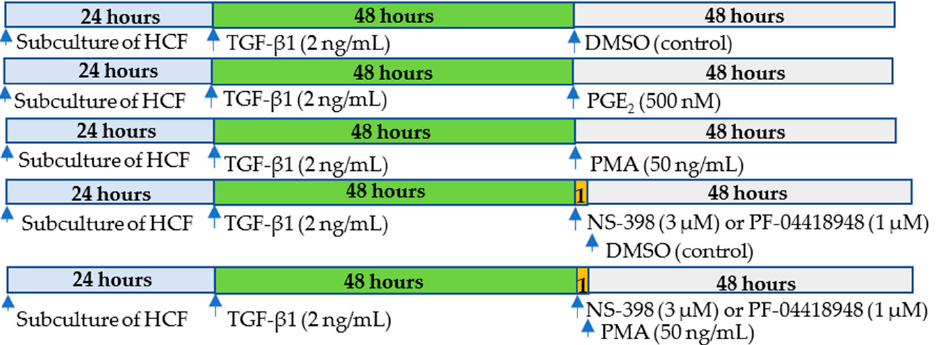
Figure 1. Protocol of studies on dedifferentiation of de novo human cardiac myofibroblasts and activation of COX-2/PGE 2 . TGF- β 1 at 2 ng/mL was added into medium for 48 hours to differentiate human cardiac fibroblasts to myofibroblasts. After changing medium withoutTGF- β 1, cells were treated with PMA, PGE 2 , or DMSO as vehicle control. To investigate the involvement of COX-2/PGE 2 activation in dedifferentiation of myofibroblasts, NS-398 (a selective COX-2 inhibitor) or PF-04418948 (a selective EP2 receptor antagonist) was added 1 hour before the treatment. The protein expression of α -SMA was detected at the end of 48 hours after treatment of the above agents. HCF: Human cardiac fibroblast.